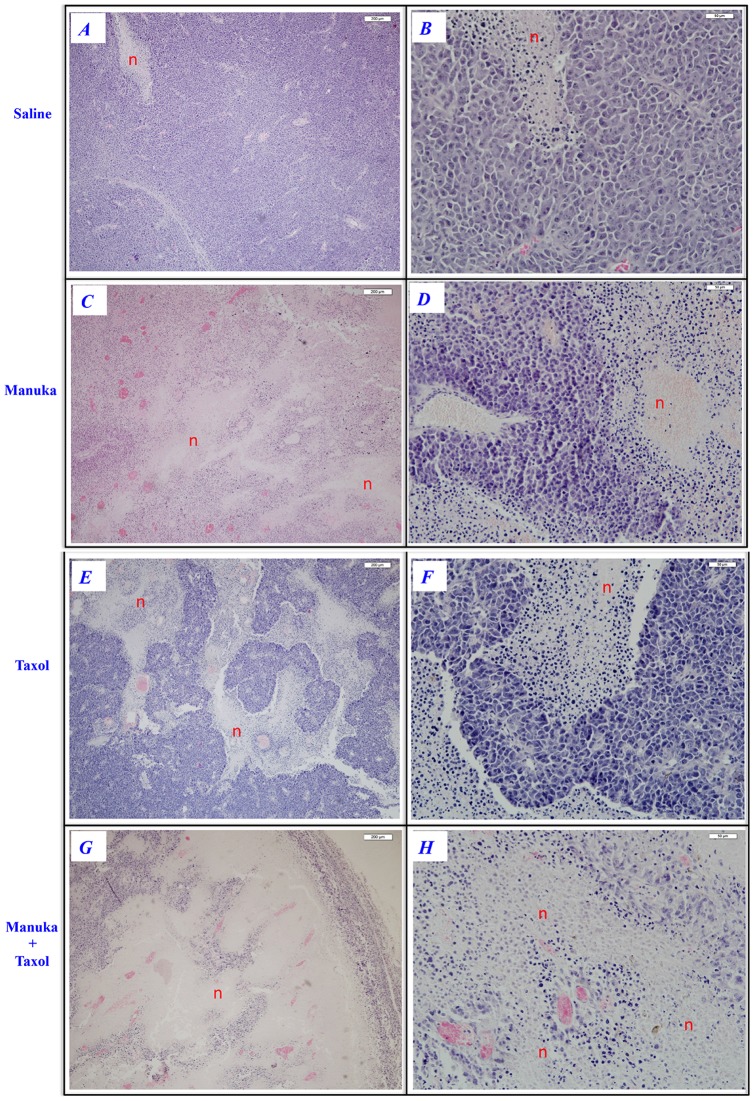
Extent of tumor necrosis in experimental groups following various treatments.Tumors were excised from animals at day 20–24 post treatment with saline (panels A–B), manuka honey (panels C–D), taxol (panels E–F) or manuka+taxol (panels G–H). Tissue sections were stained with H&E, as described in Materials and Methods. For each treatment, representative images at low (panels A, C, E, G; bar = 200 µm) and high magnifications (panels B, D, F, H; bar = 50 µm) are shown. Necrotic regions are indicated (n). The results are representative of two independent experiments.